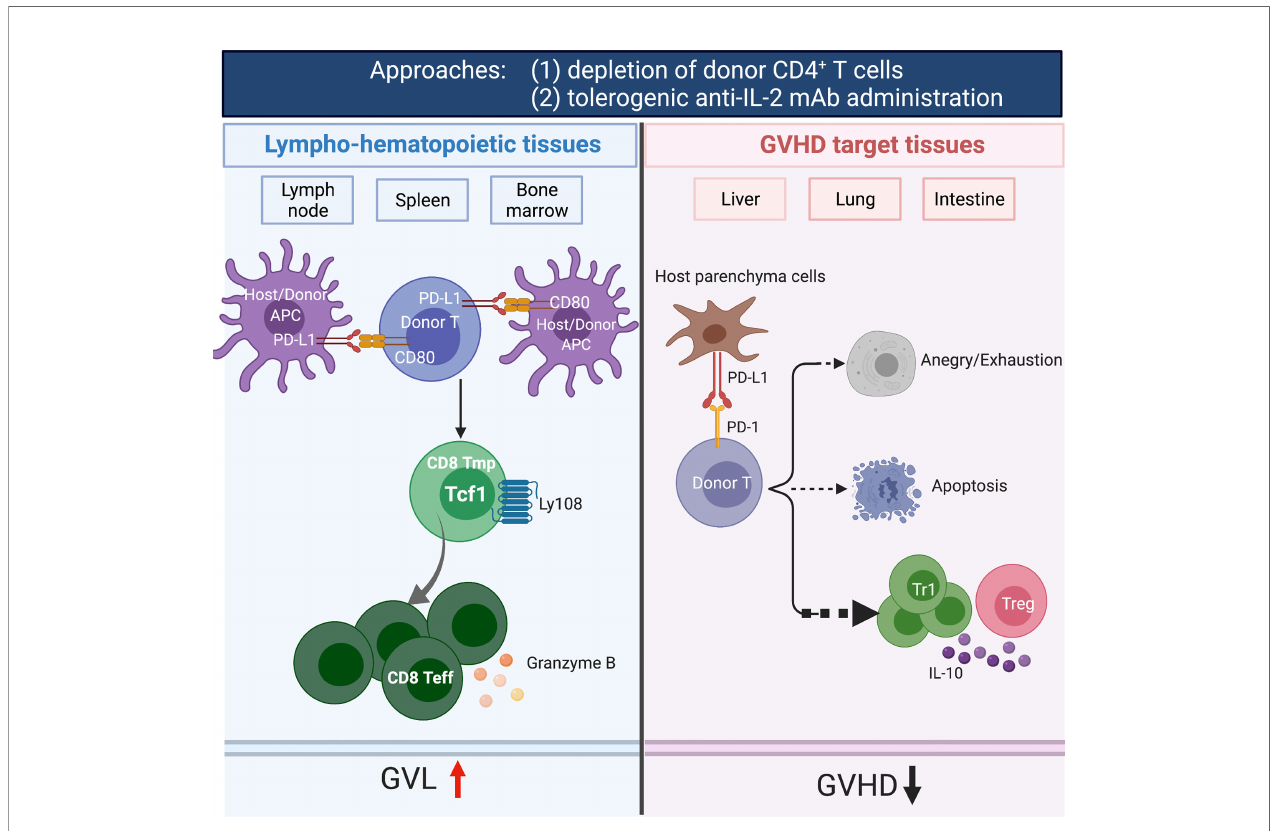
FIGURE 1 | Depletion of donor CD4 + T cells and tolerogenic anti-IL-2 mAb (JES6-1) administration prevents acute GVHD while preserving GVL activity. The depletion of CD4 + T cells by anti-CD4 mAb prevented both acute and chronic GVHD while preserving GVL activity. In GVHD target tissues, depletion of CD4 + T cells allowed host tissue PD-L1 interaction with PD-1 expressed by donor CD8 + T cells to induce anergy, exhaustion and apoptosis. In lymphoid tissues, the treatment allowed PD-L1 and CD80 interactions among lymphocytes and DCs to augment expansion of CD8 + T cells that mediating GVL activity. Furthermore, CD4 + T cells help CD8 + T cells via their production of IL-2. Administration of tolerogenic anti-IL-2 mAb (JES6) expanded IL-10 + FoxP3 - CD4 + Tr1 cells in GVHD target tissues. In addition, increased expression of granzyme B and generation of TCF-1 + CD8 + memory progenitors that can give rise to cytotoxic effector cells in lymphoid tissues, leading to effectively prevention of aGVHD while preserving GVL activity. Created with